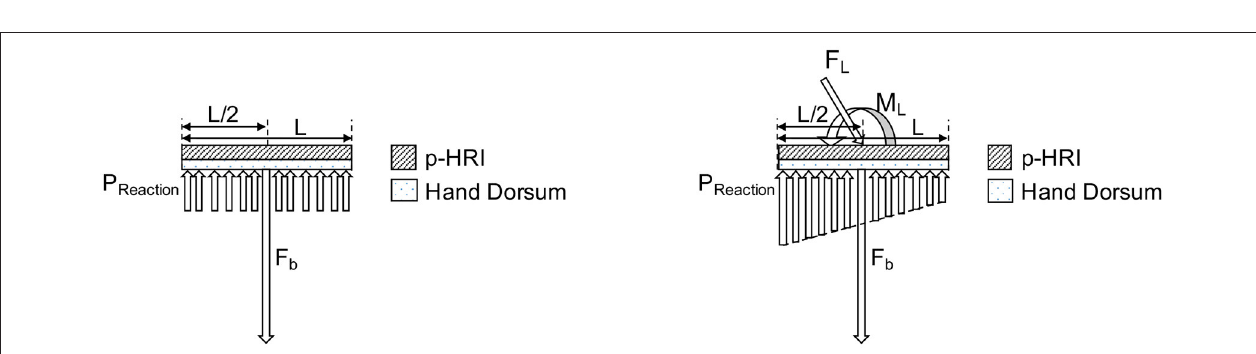
FIGURE 8 | Model of hand dorsum and PHRII with uniform stiffness, bias force ( F b ), and uniform reaction pressure ( P reaction ) distribution.